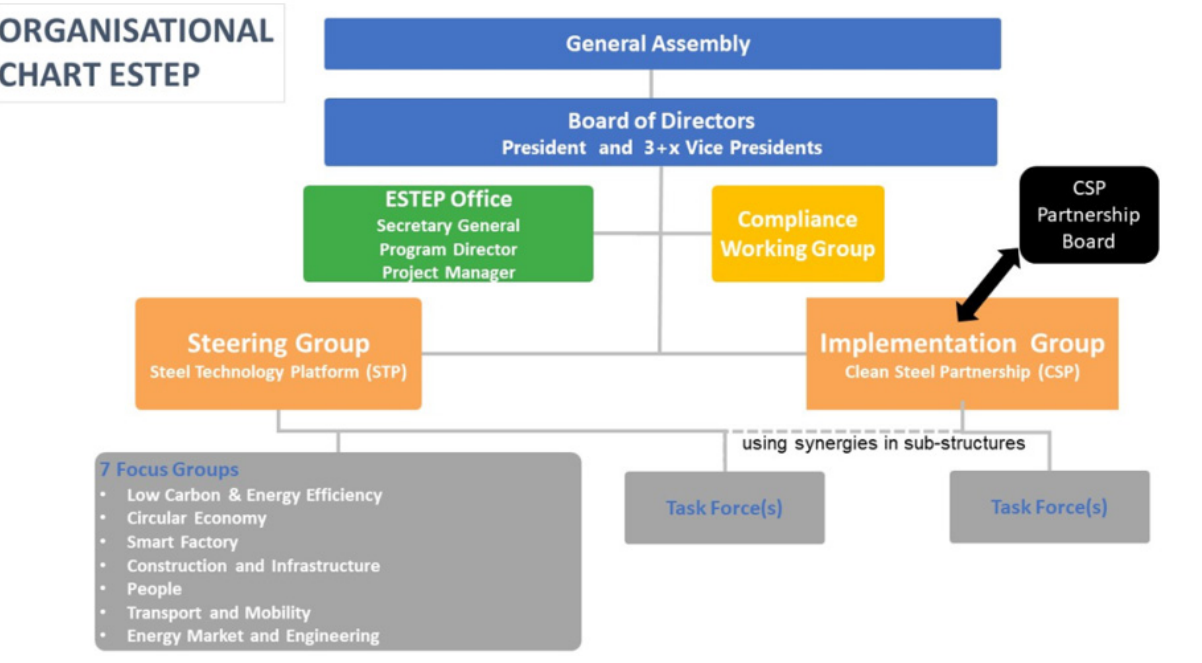
Figure 1. Organizational structure of ESTEP [70].